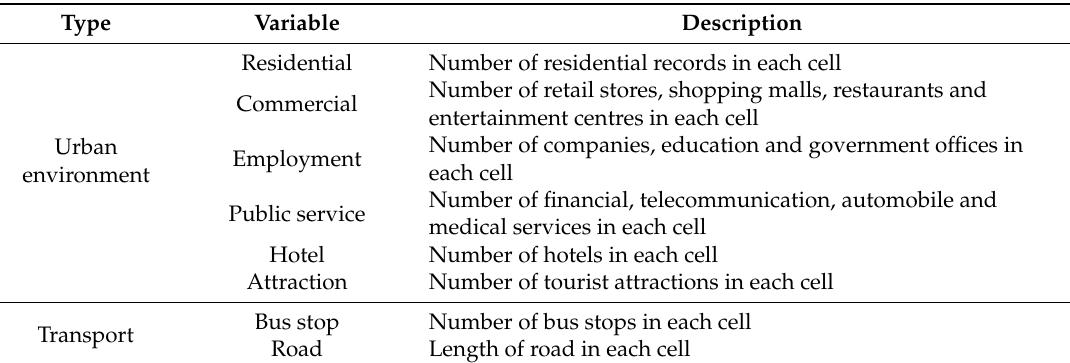
Table 1. List of explanatory variables.